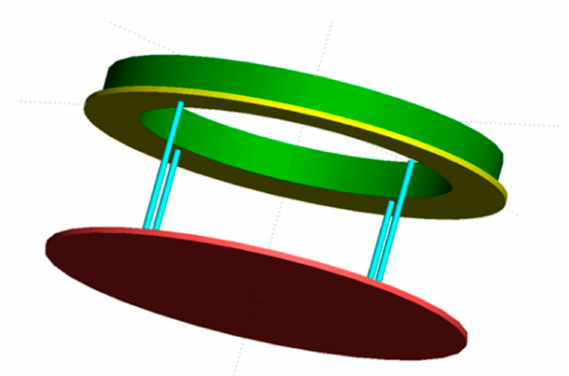
Figure 6. The platform model with moon pool.